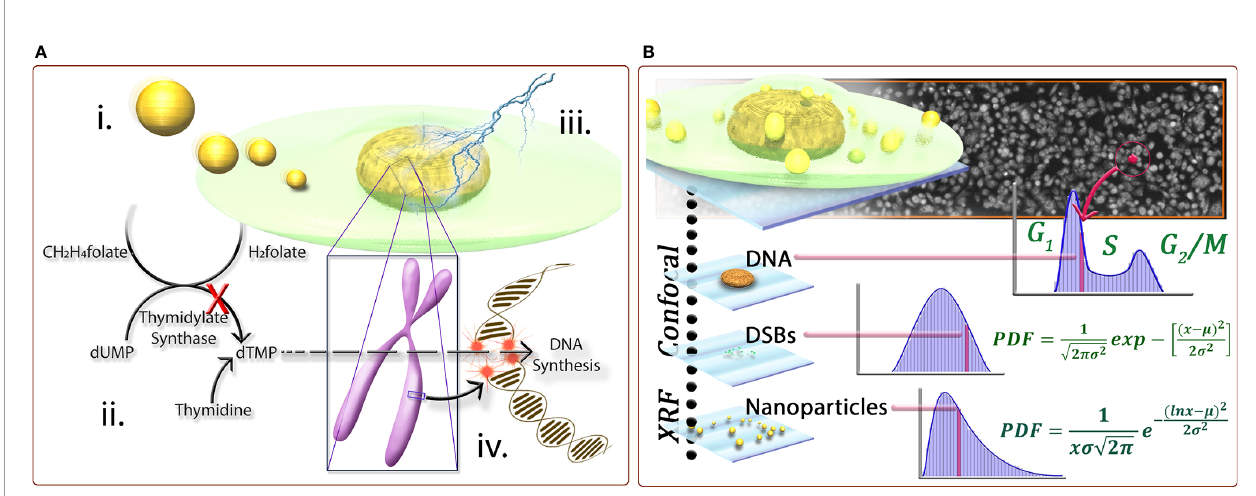
FIGURE 3 | (A) Schematic representation of the following conceptst: (i) internalization of nanoparticles by cells can lead to the down-regulation of proteins, including thymidylate synthase (TS), important for DNA damage repair response; ii. due to the down-regulation of TS, the conversion of dUMP to dTMP is inhibited; iii. subsequently, when the DNA is subjected to insult by ionizing radiation causing doublestrand breaks; and iv. the normally effective homologous recombination pathway for repairing DSB ’ s in S-phase cells is also inhibited, leading to a biological mechanism of radiosensitization. (B) A cross-correlative methodology developed provides a three-dimensional data set to compare cell populations and sub-populations with regard to nanoparticle dose − response at the single-cell level. Correlating biological markers imaged with laser scanning confocal microscopy with elemental content from synchrotron X-ray fl uorescence microscopy for cell populations provides statistically signi fi cant, descriptive analysis of cell populations with regard to biological response for a quanti fi ed number of nanoparticles. For example, only cells with comparable numbers of nanoparticles are compared, or only cells in a certain phase are compared. The population behavior can be described by fi tting functions and any individual cell from a population can be characterized by its biological markers coupled with its nanoparticle content